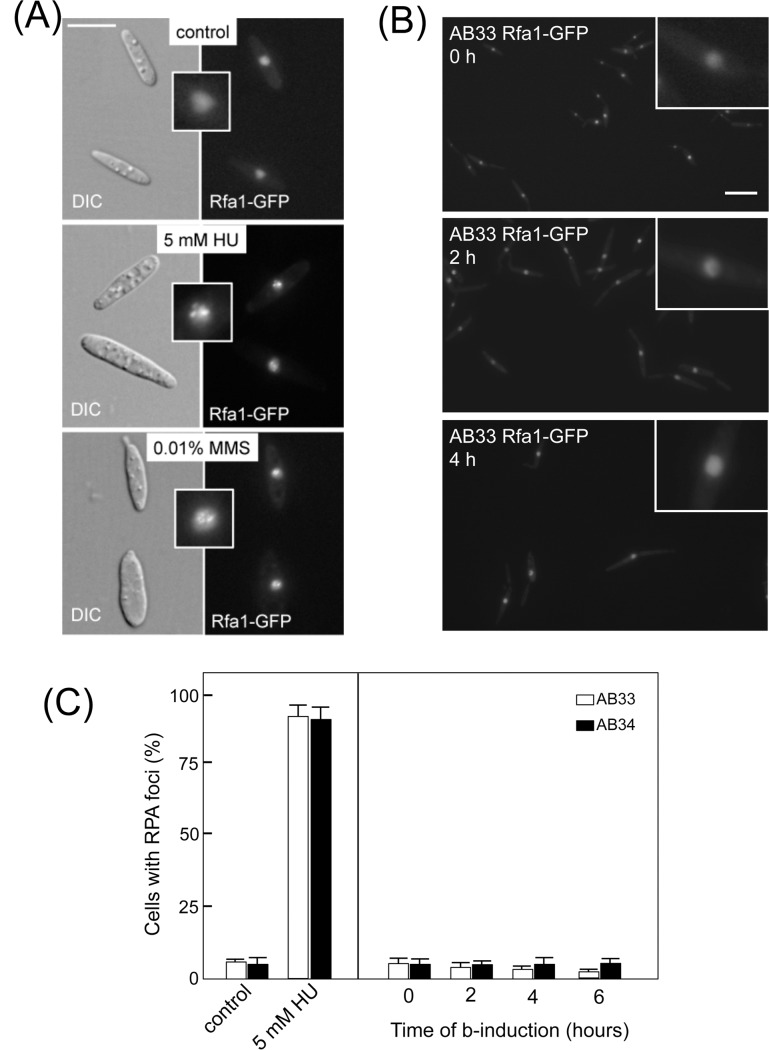
Analysis of RPA foci in the b-induced filament of U.
maydis.(A) Rfa1-GFP foci observed in a strain carrying the endogenous
rfa1 allele tagged with a triple GFP cassette and
treated with the indicated genotoxic agents. Insets showed magnification
of representative nucleus in each case. Bar: 15 μm (B). Absence
of Rfa1-GFP foci after b-induction in the UMT011 strain (AB33 derivative
carrying the rfa1-3GFP allele). Representative images
of cultures at the indicated times are shown. Insets show magnification
of representative nucleus in each case. Bar: 10 μm. (C)
Quantification of cells showing RPA-GFP foci. The graph shows the result
from two independent experiments, counting more than 50 cells each.
Means and SDs are shown.